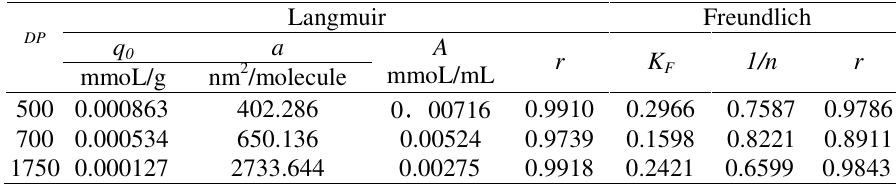
Table 3. Langmuir and Freundlich isotherm constants at 25 °C Langmuir Freundlich